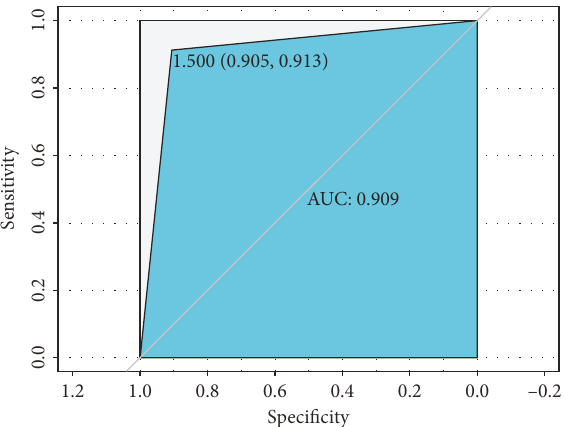
Figure 5: Plot of ROC results for random